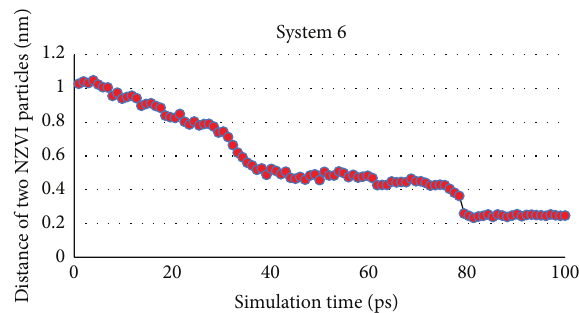
Figure 13: Distance change of two NZVI particles in whole simulation process of system